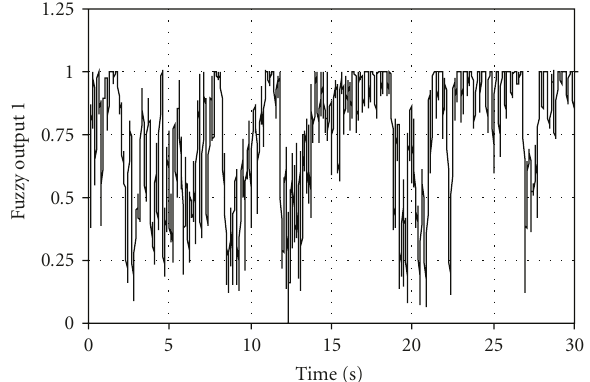
Figure 7: Output from stage one of the FLC, with a = 2.